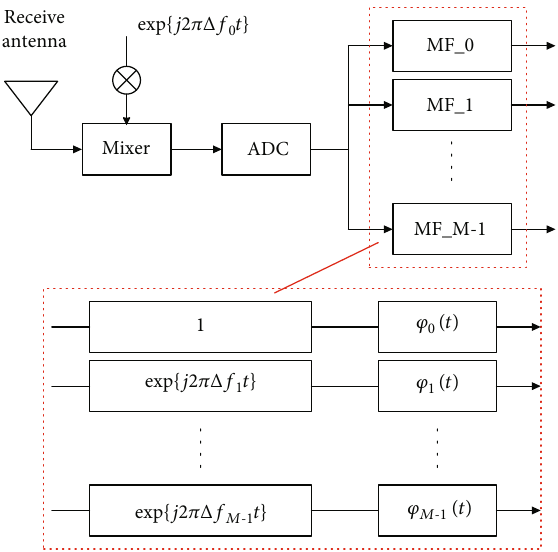
Figure 2: Matched fi ltering signal processing at the